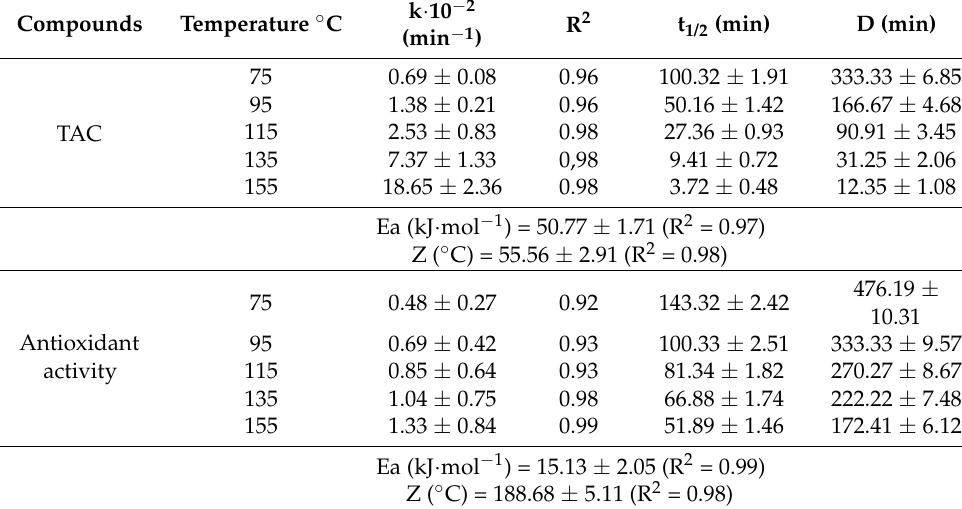
Table 2. The degradation kinetic parameters (degradation rate constant—k, correlation coefficient — R 2 , decimal reduction time—D, z-value, activation energy—Ea, and half-life values—t 1/2 ) of the total anthocyanins content (TAC) and antioxidant activity from the red onion skins extract heat-treated at different